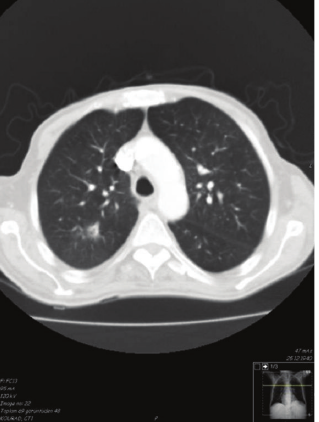
Figure 2: Computerized tomography of